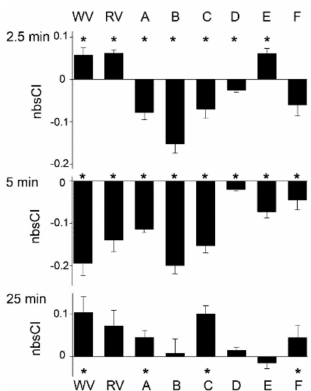
Figure 4. Summary of temporal profiles for xCELLigence—based bio-impedance to application of venom fractions from Australian scorpion Hormurus waigiensis to GCaMP5G-RyR1-HEK293 cell monolayers. Normalized background subtracted cell index data (nbsCI). WV, whole venom; RV, reconstituted venom; ( A ), venom Pool A (peak samples 1, 2a, 2b); ( B ), Pool B (peak samples 3, 4); ( C ), Pool C (peak samples 5, 6, 7); ( D ), Pool D (peak samples 8, 9, 10); ( E ), Pool E (peak sample 11); ( F